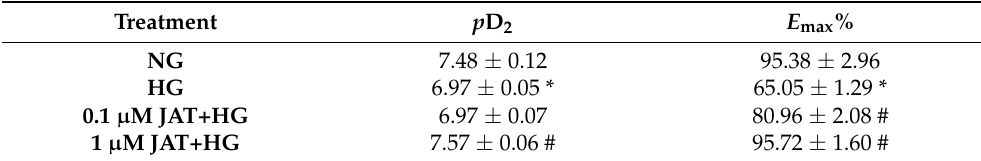
Figure 2. Vasoprotective effect of jatrorrhizine (JAT) in mouse aortas ex vivo. ( A , B ) Effect of JAT and high glucose (HG; 30 mM, 48 h) on the acetylcholine (ACh)-induced endothelium-dependent relaxations (EDRs) in aortas from C57BL/6J mice as compared with control (NG; mannitol added as osmotic control). ( C ) Sodium nitroprusside (SNP)-induced endothelium-independent relaxations were not affected. ( D ) Diet-induced obese (DIO) and diabetic mouse model was induced by high-fat diet (HFD; 45% kcal% fat, 10 weeks) plus single intraperitoneal injection of streptozotocin (STZ; 120 mg/kg) and ex vivo treatment of JAT (1 μ M, 24 h) improved ACh-induced relaxations in aortas. ( E ) SNP-induced relaxations were unaffected. Results are mean ± SEM of 4 experiments. * p < 0.05 vs. NG; # p < 0.05 vs. HG; † p < 0.05 vs. DIO. Table 1. Dilator concentrations in negative logarithm inducing 50% of maximum response ( p D 2 ) and maximum relaxation ( E max %) for acetylcholine (ACh)-induced endothelium-dependent relaxations (EDRs) of mouse aortas treated with high glucose (HG; 30 mM, 48 h) and different concentrations of jatrorrhizine (JAT), with mannitol as control (NG). Results are mean ± SEM of 4 experiments. * p < 0.05 vs. NG; # p < 0.05 vs.